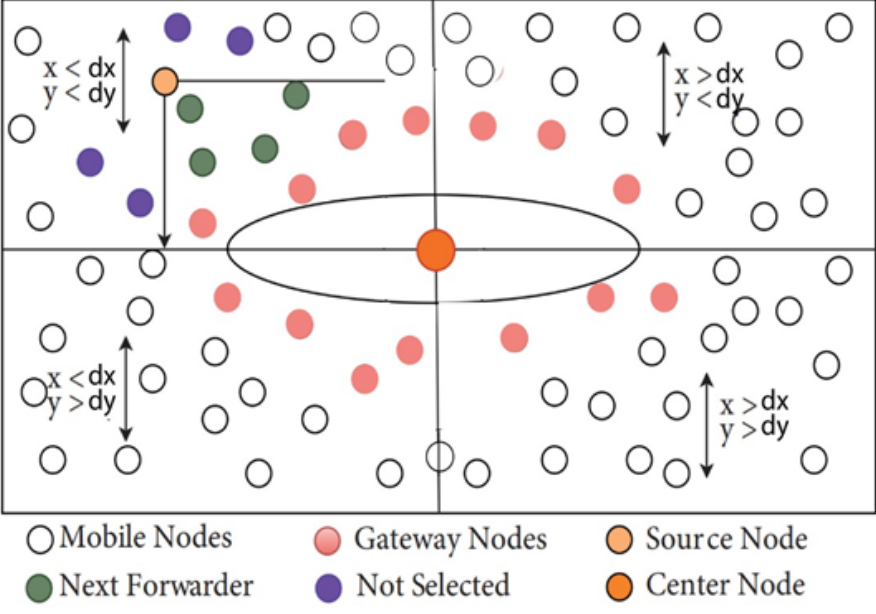
Figure 3. Selecion of next forwaded